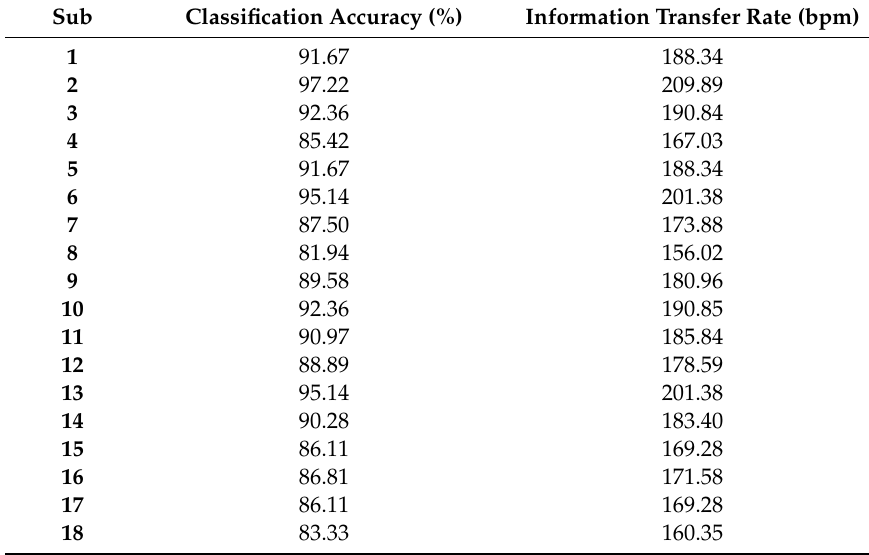
The numbers represent number of subjects. The level of tiredness was evaluated on a scale of 1 to 5: 1 = not tired; 2 = little tired; 3 = moderately tired; 4 = tired; and 5 = highly tired. Table 2. Classification accuracy and information transfer rate of proposed framework with 1 s epoch lengths in offline experiment.